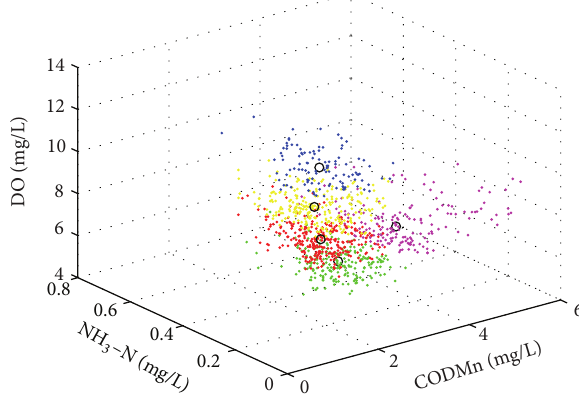
Figure 2: The convergence process of the objective function in FCM clustering and FFCM clustering. Table 2: The cluster center of FFCM clustering.